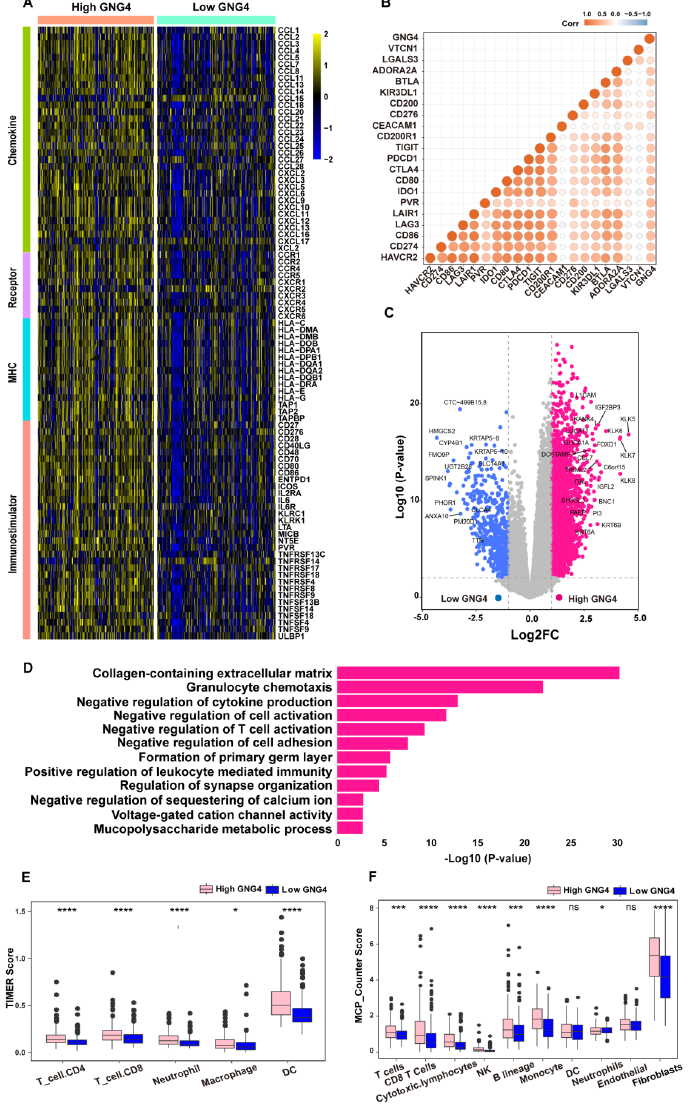
Figure 2. High-GNG4 group exhibits the high expression of immune-related molecules. ( A ). Differ- ential expression of 122 immunomodulators (chemokines, receptors, MHC, and immunostimulators) between high-GNG4 and low-GNG4 groups in BLCA. ( B ). Correlation of GNG4 with 20 inhibitory im- mune checkpoints. The color indicates the Spearman correlation coefficient. ( C ). Volcano map shows differentially expressed genes between high-GNG4 and low-GNG4 groups in BLCA (high: logFC > 1 and log p -value > 2; low: logFC < − 1 and log p -value > 2). ( D ). Functional comments and pathway enrichment of the genes with GNG4 co-expression genes. ( E , F ). Estimation of the abundance of various types of immune cells between the high-GNG4 and low-GNG4 groups using TIMER_counter and MCP_counter algorithm. *, p -value ≤ 0.05; *** p -value ≤ 0.001; ****, p -value ≤ 0.0001; ns, p -value >